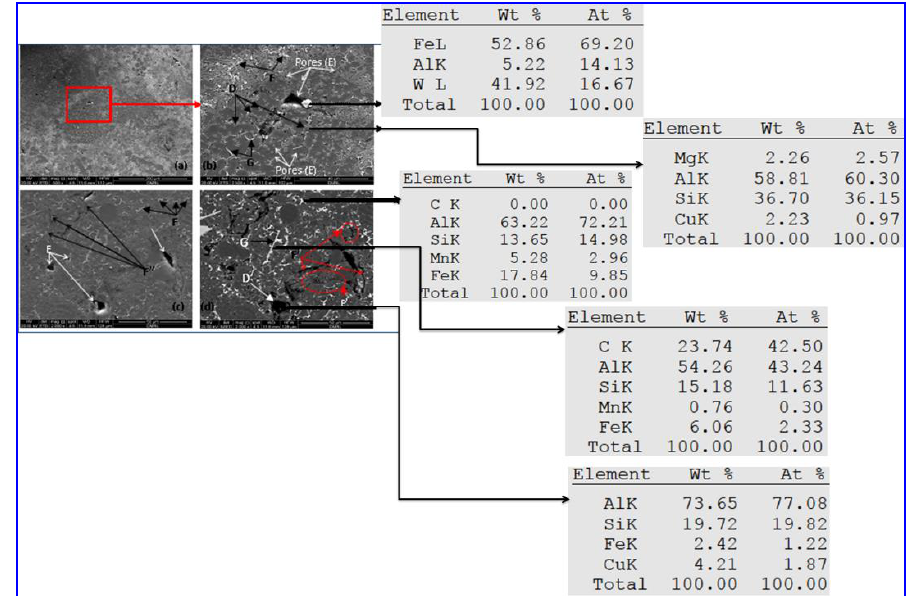
Figure 15: Representative SEM microstructure of connectors – (a,b) transverse section of connector 1, longitudinal section of connector 2 in SE I and BSE (d) modes , Etchant: Keller’s reagent.